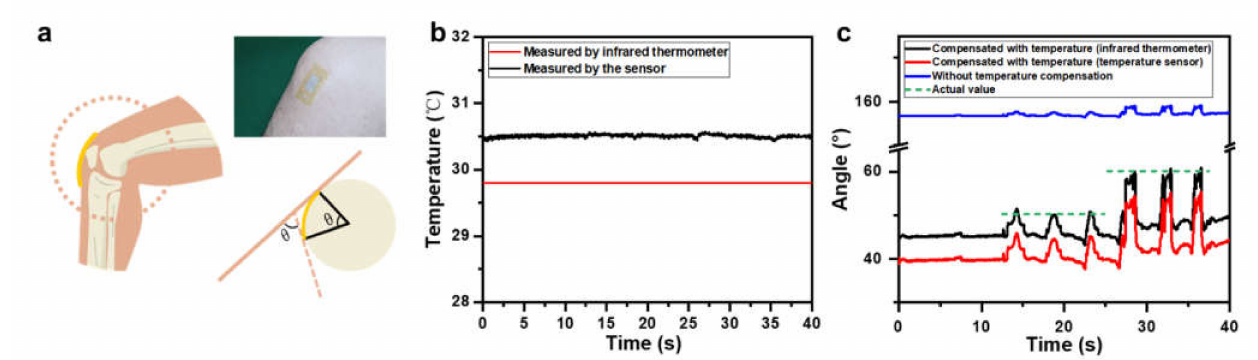
Figure 11. ( a ) Schematic diagram and optical photograph of a two-sensor system attached to the surface of a knee. ( b ) Temperature measured by an infrared thermometer and by a temperature sensor when attached to the knee. ( c ) Angle measured with and without temperature compensation during joint movement. The temperature used for compensation was measured by either an infrared thermometer or the temperature sensor. The actual value is also plotted as a